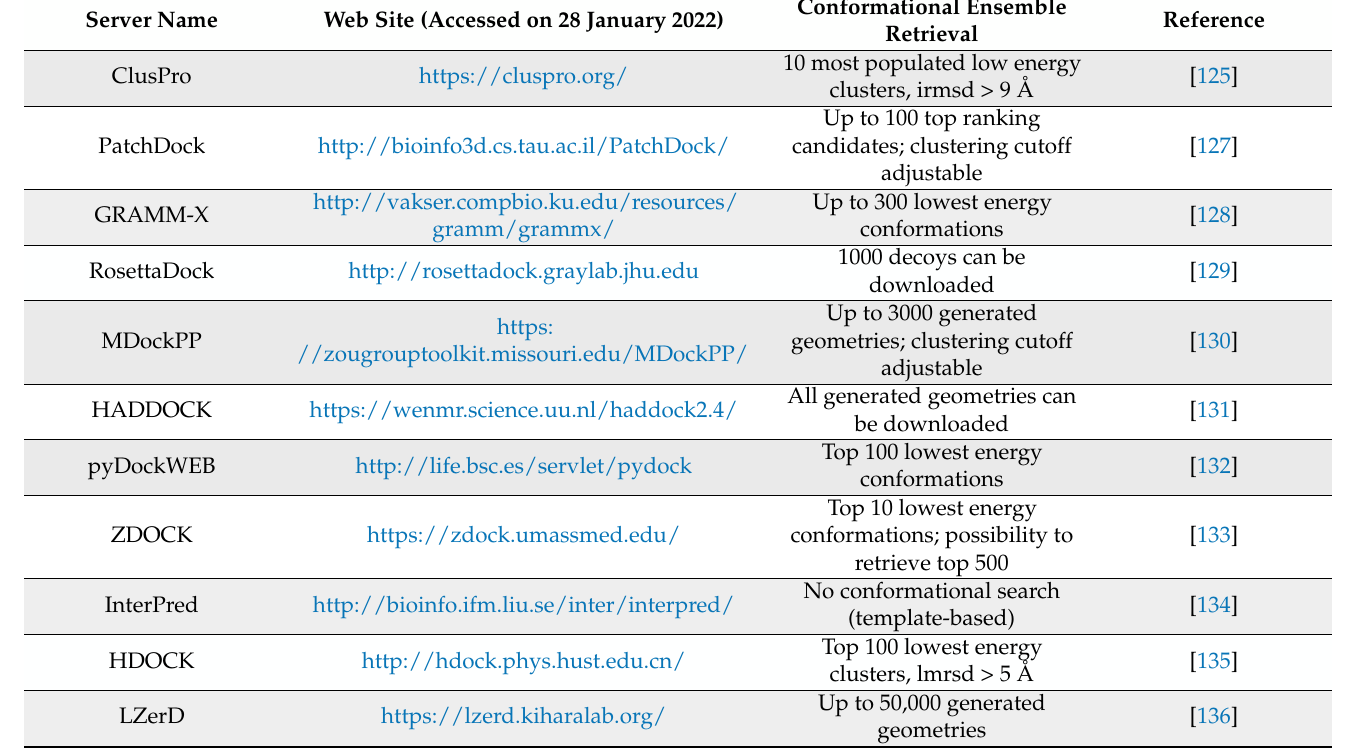
Table 2. List of automatic docking web